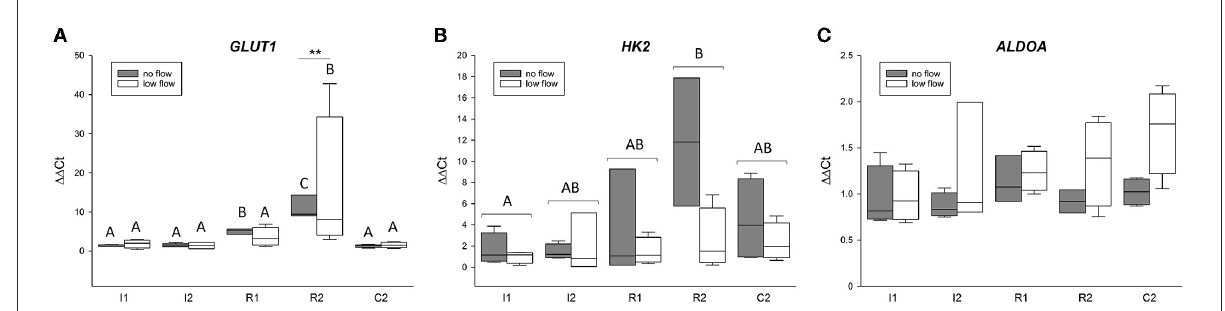
FIGURE1 The mRNA expression of HIF1 α target genes is upregulated in the equine jejunum epithelium after 1 and 2h of ischemia and reperfusion, respectively. Gene expression of GLUT1 (A) , HK2 (B) , and ALDOA (C) is given relative to control tissue before onset of ischemia (C1), which was set to 1. Different letters indicate significant differences between the time points ( p < 0.05, two-way RM ANOVA with post-hoc Holm-Sidak test). As there were interactions between time point and ischemia model for GLUT1 , the comparison between time points is made individually for each group and asterisks indicate significant differences between the ischemia models at the same time point (** p < 0.01) for this gene. Otherwise, the comparison between the time points is made over both groups jointly as indicated by brackets. Boxes and error bars show the median, 10th, 25th, 75th, and 90th percentiles (no flow: gray; low flow: white); N = 5 (no flow) or 4 (low flow).